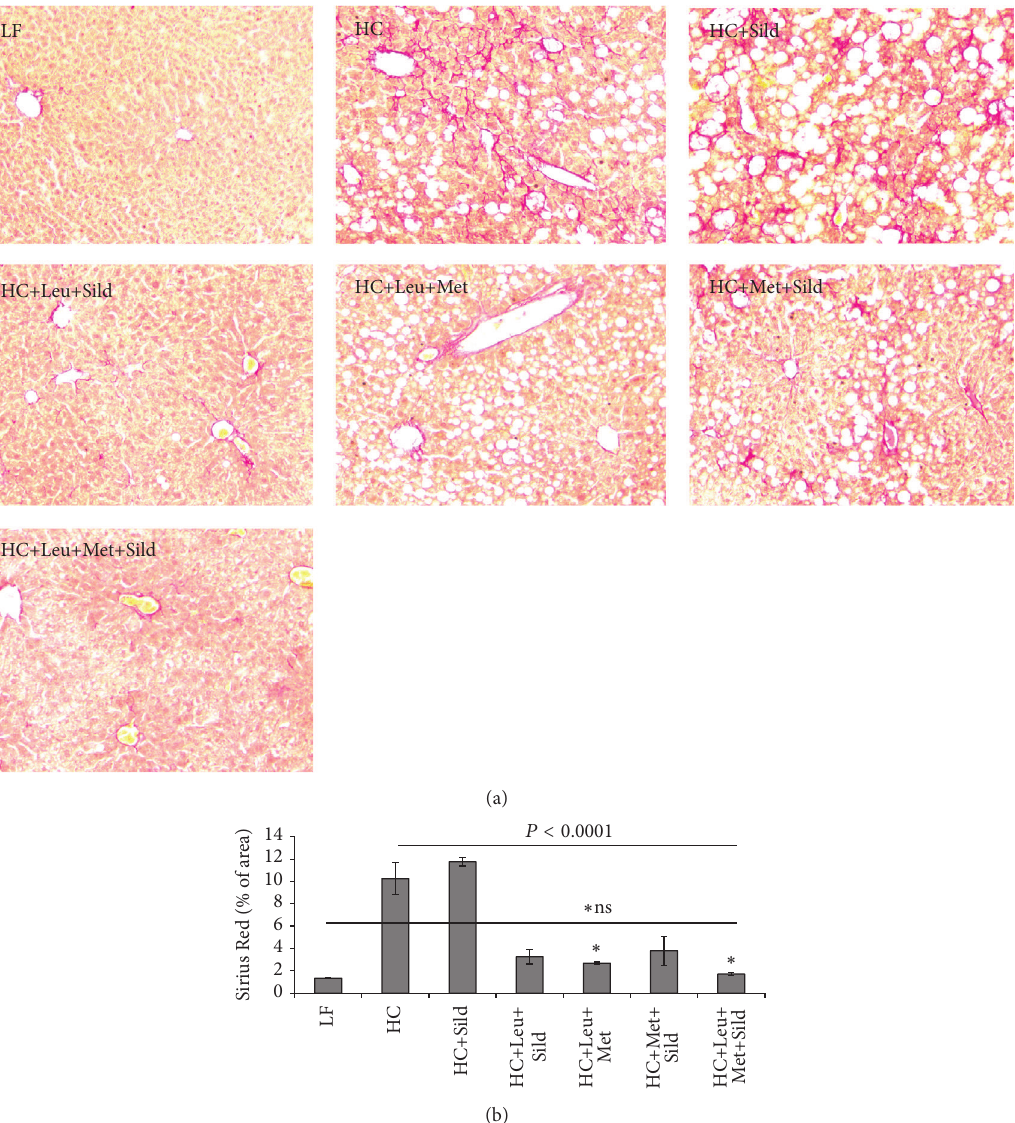
Figure 10: Met-Leu effects on hepatic fibrosis in mice. Mice were fed a low-fat (LF) diet or high-fat atherogenic (HC) diet for 6 weeks and then randomized to the indicated treatment groups for an additional 6 weeks. (a) Liver sections were stained with Picro Sirius Red for collagen at the end of the study ( 𝑛 = 3 ). Representative images for each group are shown. (b) Quantitation of Picro Sirius Red staining, calculated as % of the examined area. Data are expressed as mean ± SEM ( 𝑛 = 3 ). Sild: sildenafil, Met: metformin, and Leu: leucine. ∗ indicates groups which are not significantly different from